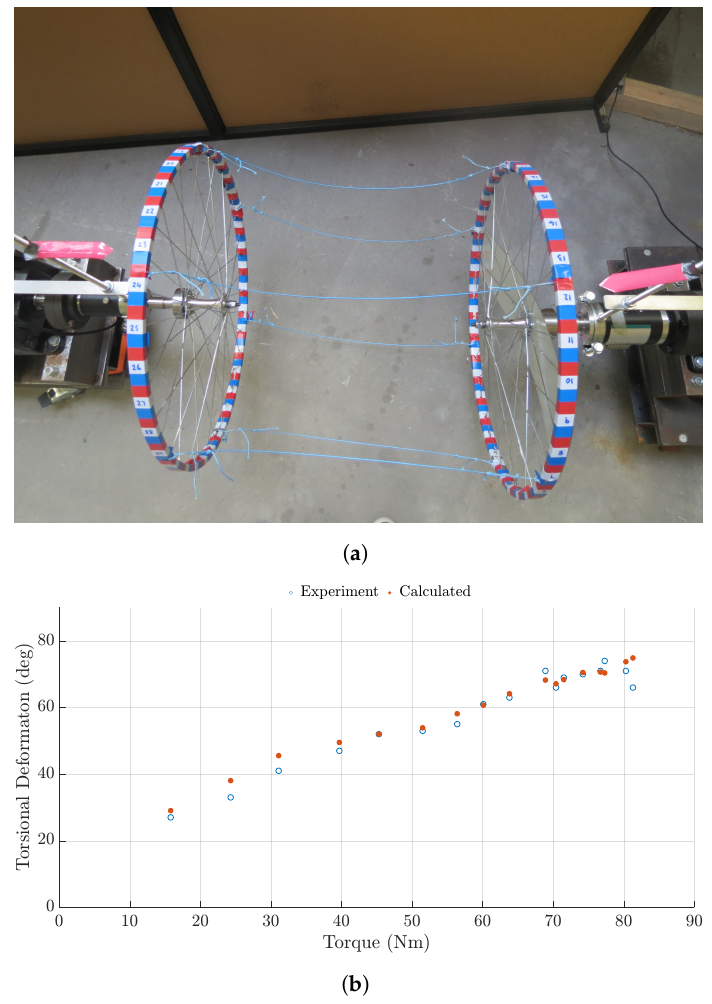
Figure 9. TRPT laboratory test set-up and results, 30 kg axial load case. ( a ) TRPT section lab testing with two wheels; ( b ) Lab testing results compared to calculated torsional